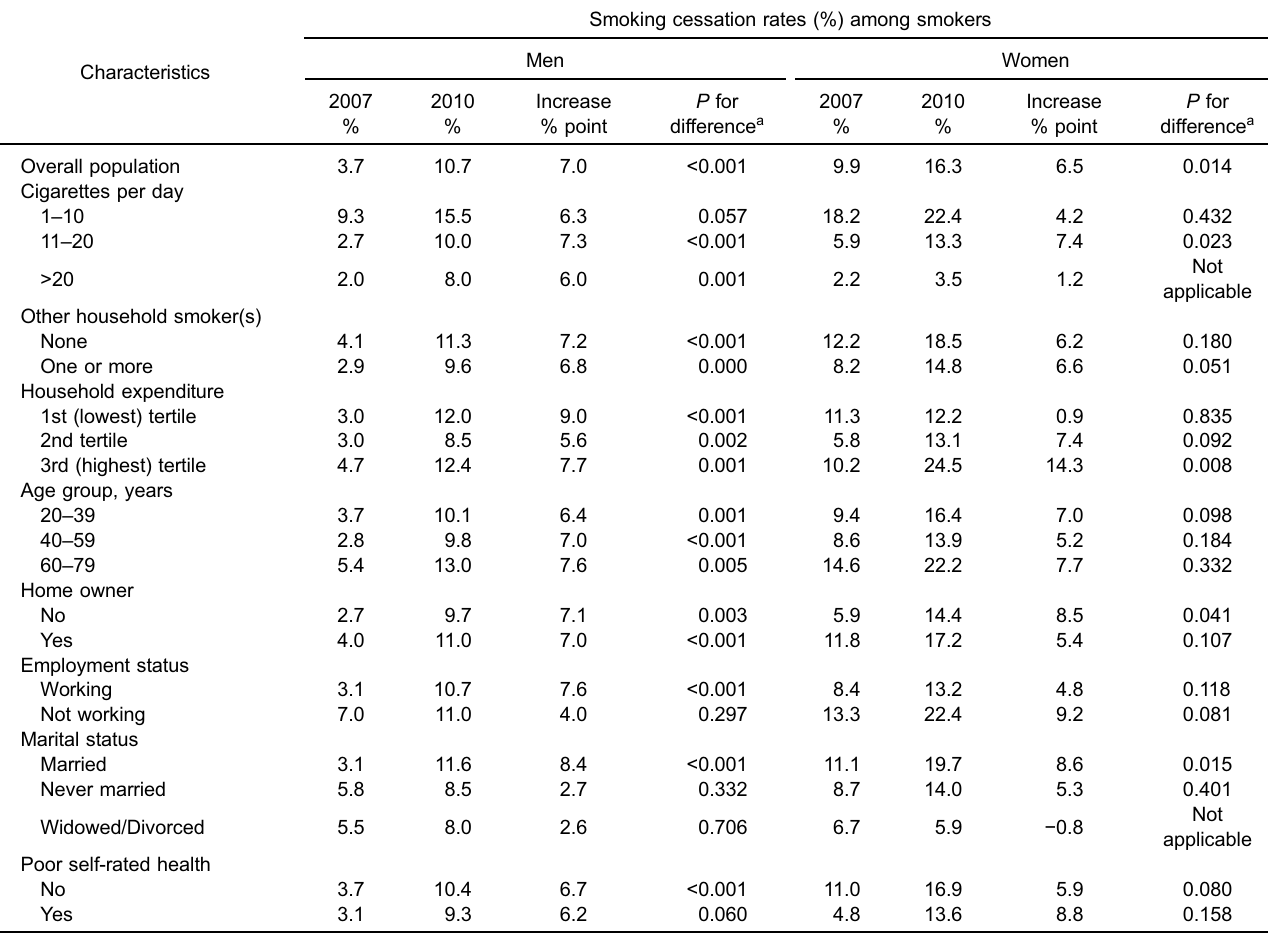
Table 2. Smoking cessation rates (during 5 months of follow-up) and increase (absolute value) in 2010 compared with 2007 among smokers according to baseline characteristics